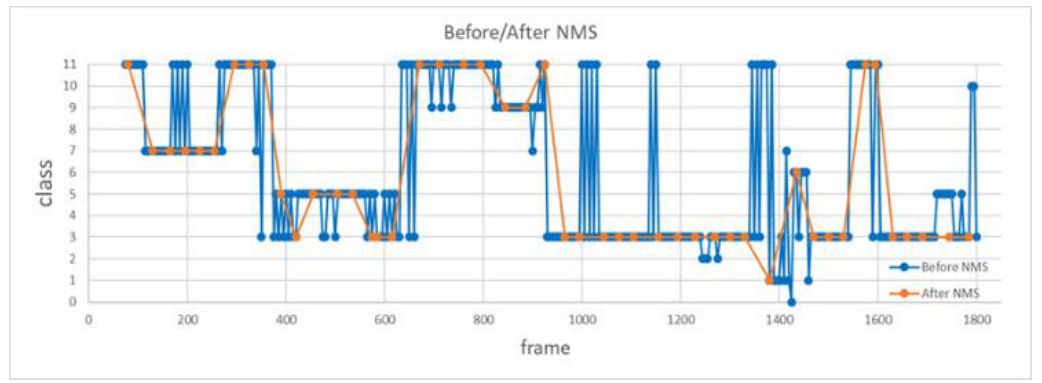
Figure 16. Comparison of recognition results with and without using NMS.